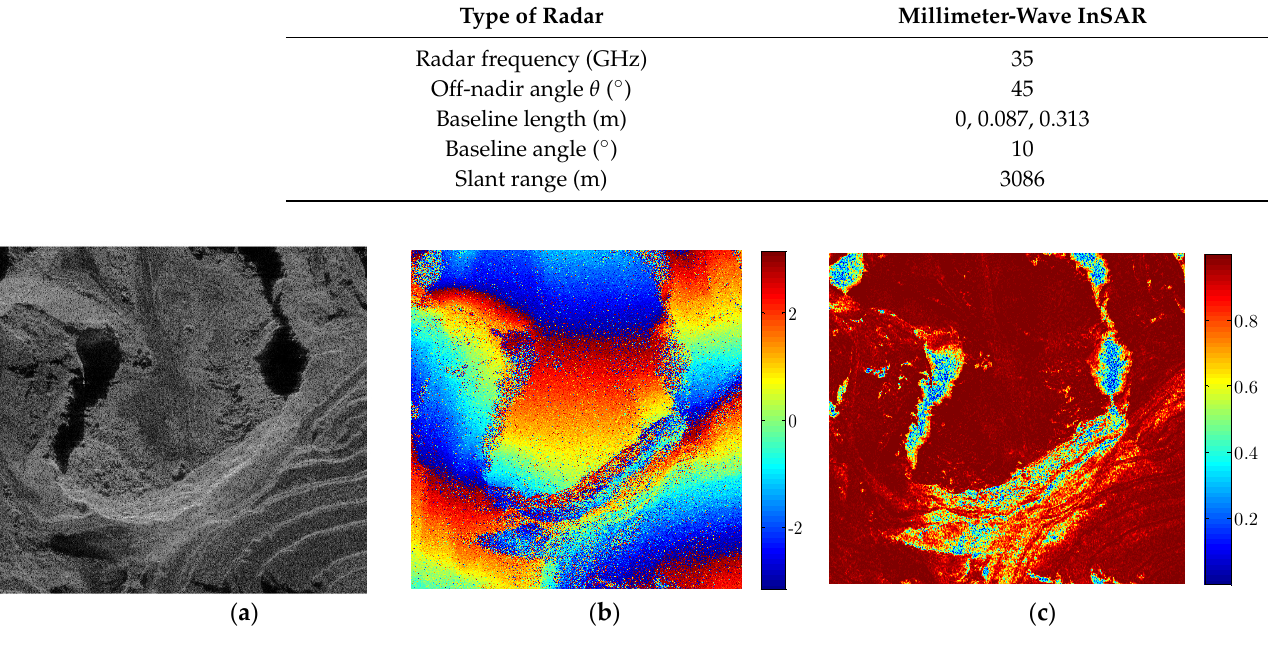
Figure 3. Raw SAR data. ( a ) SAR amplitude figure; ( b ) Long baseline interferometric phase pattern; ( c ) Long baseline coefficients. The horizontal axes represent the azimuth direction, and the vertical axes represent the slant range direction.